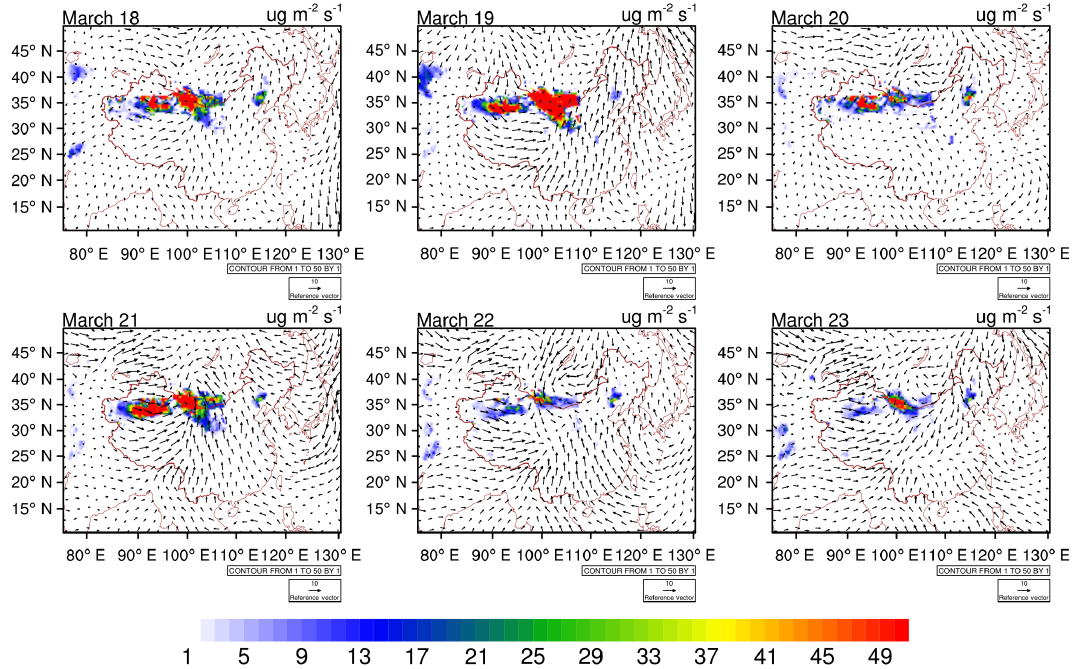
Figure 9. Spatial distributions of the daily dust emission (µgm − 2 × s − 1 ) over East Asia during the simulation period from WRF-Chem simulations. The arrows represent the wind vectors at 10m (m × s − 1 )